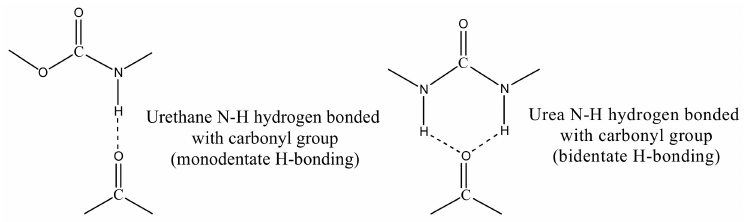
Figure 7. Mono- and bidentate hydrogen bonding between hard segments of in situ synthesized PUU of